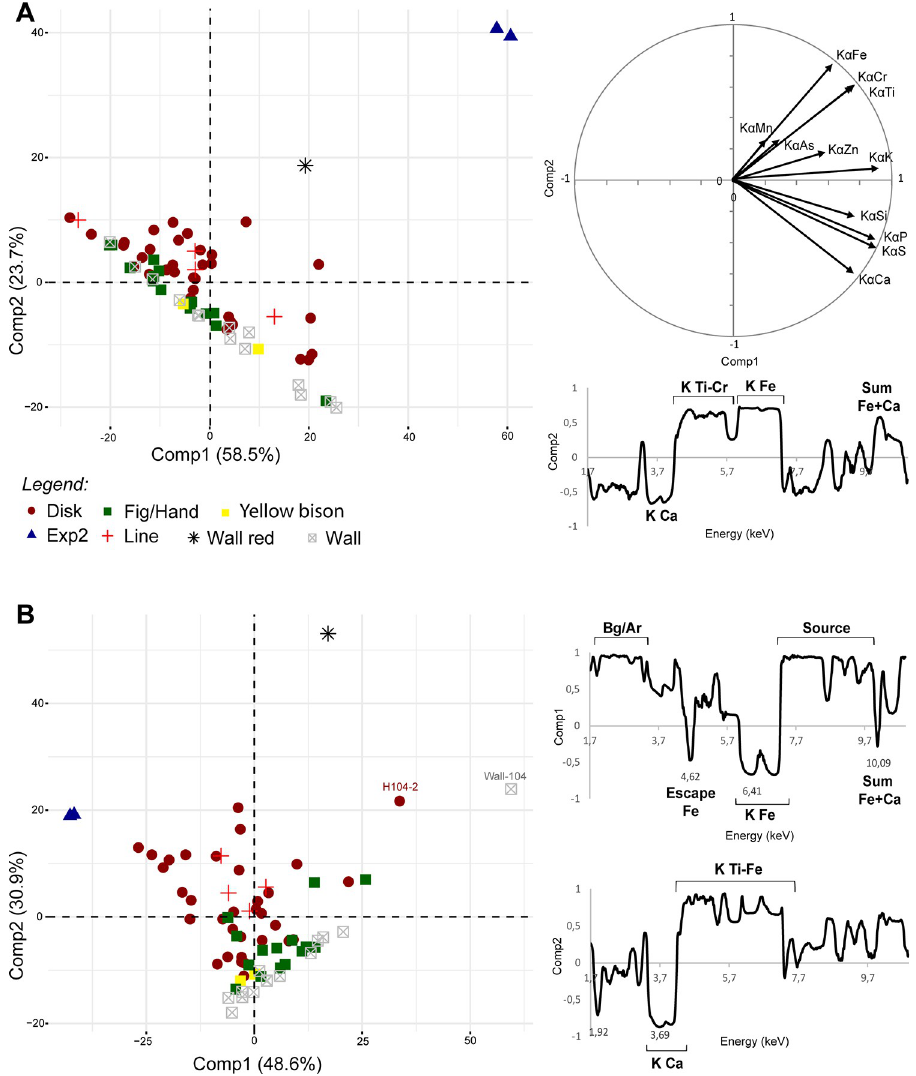
Fig 7. Results of PCA1 and PCA2 carried out on the raw spectra (A) and normalised spectra (B). On the right: coordinates of individuals; on the left: coordinates of